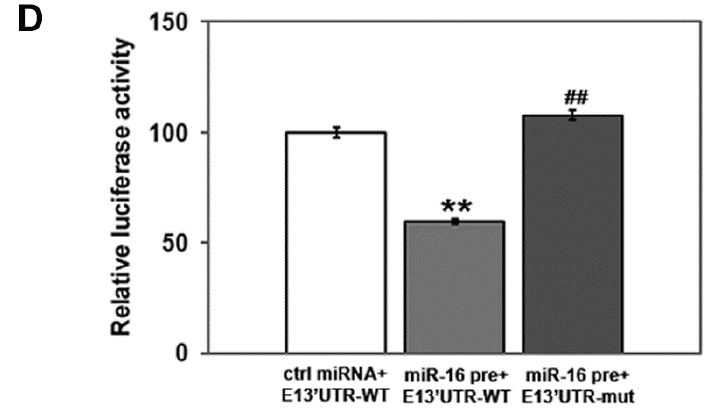
Figure 3. miR-16 destabilizes cyclin E1 mRNA via binding its 3'UTR. ( A ) hsa-miR-16 sequence and its target sequences in the cyclin E1 3'UTR ( top ), or ( bottom ) the cyclin E1 3'UTR with mutations in the miR-16 seed sequences (cyclin E1 3'UTR mut; changed bases are underlined). After a 48 h transfection of MCF7 cells with miR-16 precursor or antagomir; ( B ) cyclin E1 and HuR mRNA levels were assessed by qRT-PCR; ( C ) Cyclin E1 mRNA stability was assessed by qRT-PCR after addition of actinomycin D. Data were normalized to GAPDH and expressed as relative mRNA levels. Numbers indicate the mRNA half-life in hours (h) in cells treated with control miR (ctrl), miR-16 precursor (pre) or miR-16 antagomir (anti); and ( D ) MCF-7 Cells were co-transfected with control miRNA (ctrl miRNA) or miR-16 precursor (miR-16 pre), pMIR-REPORT β -gal control vector and pMIR-REPORT luciferase vector containing either the cyclin E1 3'UTR (E13'UTR-WT) or the cyclin E1 3'UTR with miR-16 seed sequence mutations (E13'UTR-mut, Figure 2a). Cell extracts were prepared 24 h after transfection, and luciferase activity measured using the Dual-Light System. The relative luciferase activity after normalization to pMIR-REPORT β -gal control plasmid is shown. n = 4, ** p < 0.01 versus ctrl miRNA; ## p < 0.01 versus miR-16 pre+